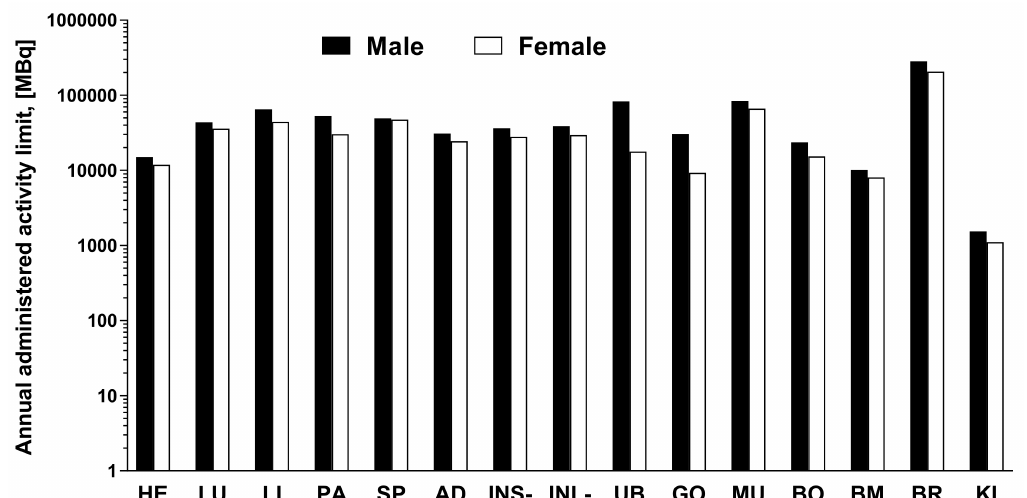
Figure 6. The maximum estimated administered dose (MBq) of [ 68 Ga]Ga-NO2A-[Nle13]-Col calculated from respective organ effective dose (mSv/MBq) and the annual limit (mSv) for the organs in compliance with European Nuclear Society data. The y-axis is in logarithmic